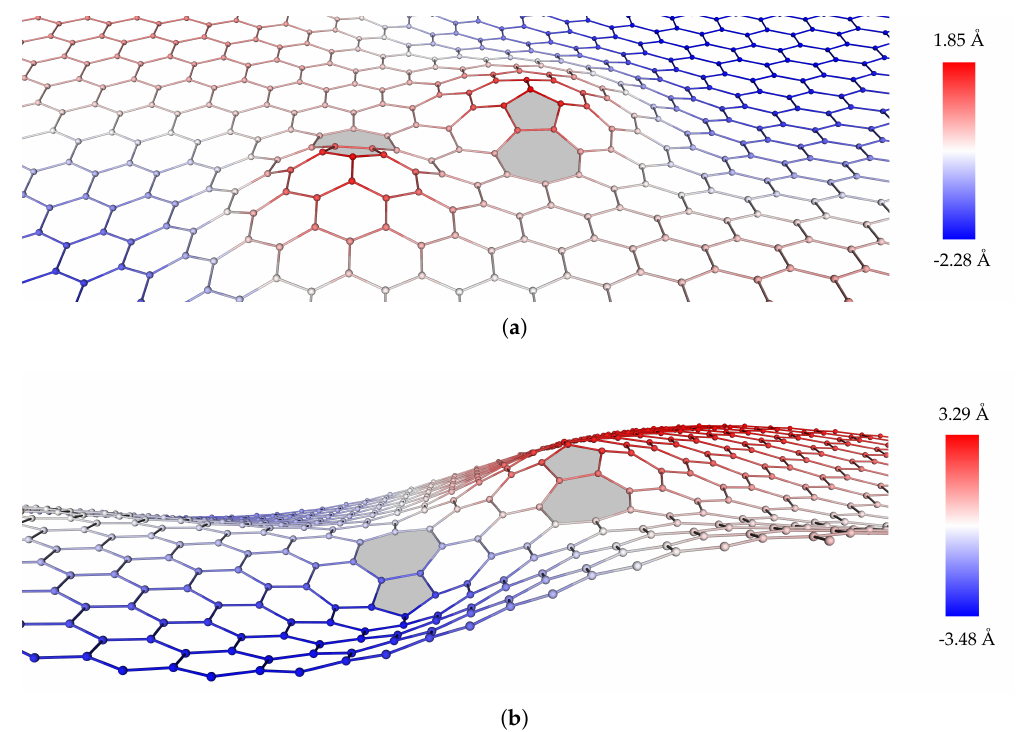
Figure 7. Symmetric ( a ) and antisymmetric ( b ) stability modes in graphene. The color code indicates the out-of-plane position of the atoms.